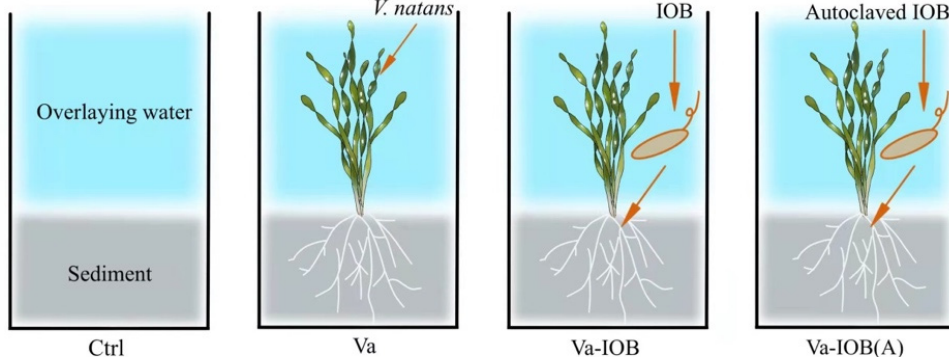
Figure 1. Overview of the experimental setup and treatment arrangement. Ctrl, no V. natans planting or iron-oxidizing bacteria (IOB) inoculation; Va, planting V. natans without IOB inoculation; Va-IOB, planting V. natans with IOB inoculation; Va-IOB(A), planting V. natans with autoclaved IOB inoculation.